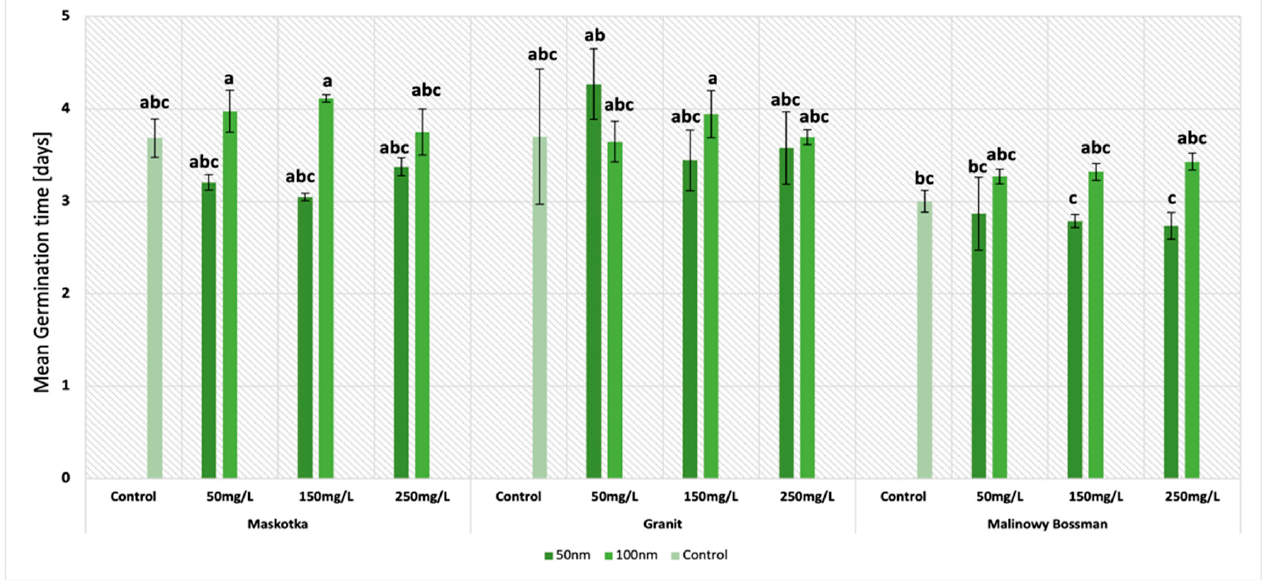
Figure 3. Effect of zinc oxide NPs on the mean germination time (MGT) of tomato seeds after 5 days of incubation. All data are the mean of 3 replicates and vertical bars demonstrate standard deviation (±SD). Different letters indicate the significant differences for p -value ≤ 0.05 (Table A1).